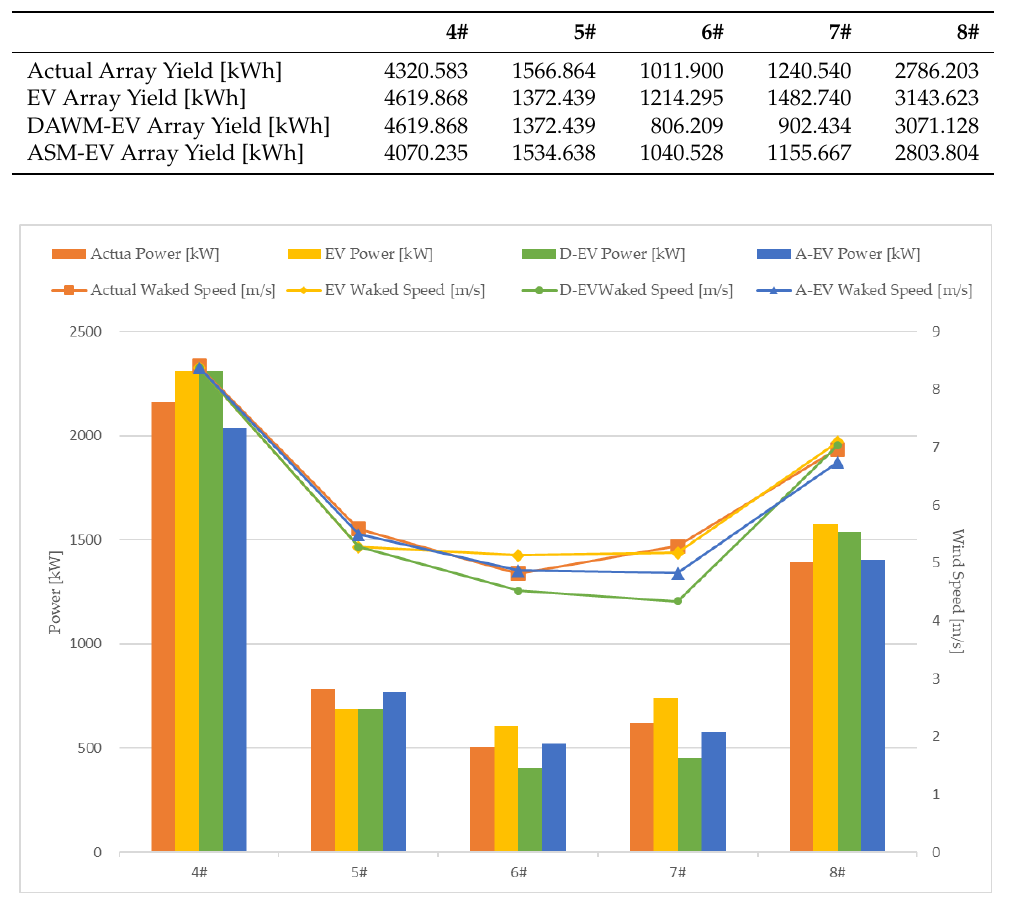
Figure 10. Average wind speed and average power during the analysis